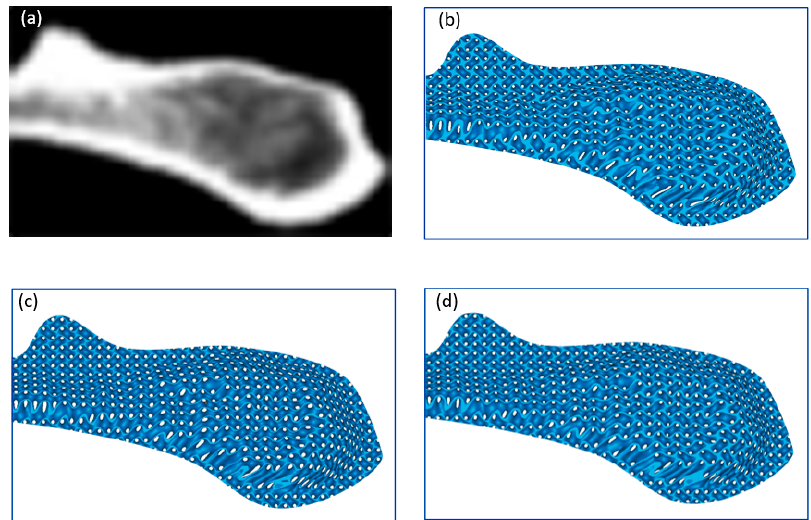
Figure 7. A generated FGS with programmable pore size using two methods: ( a ) a CT image of a bone tissue, ( b ) a constructed FGS based on the specified relative density, ( c ) a generated FGS with varying unit cell size and constant level parameters based on the expected unit cell size distribution, and ( d ) adjusted level parameters to obtain a programmable pore size based on ( c ).